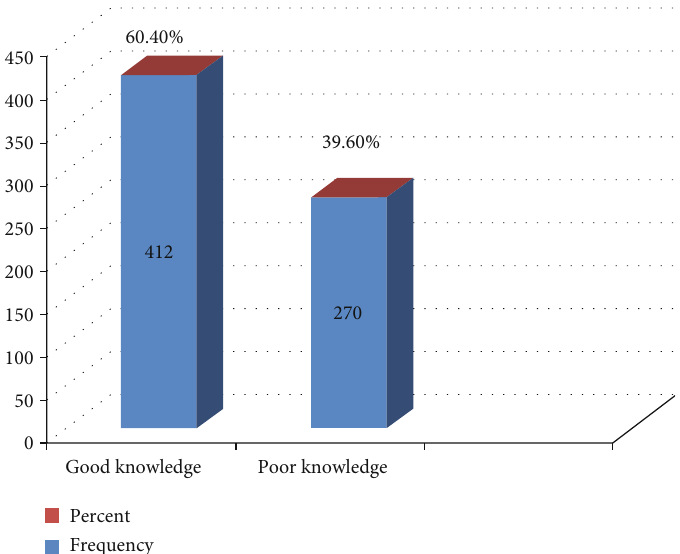
Figure 1: Knowledge of clients about immunization in Wadla district, North Wollo, Amhara regional state, northeast Ethiopia, 2019.